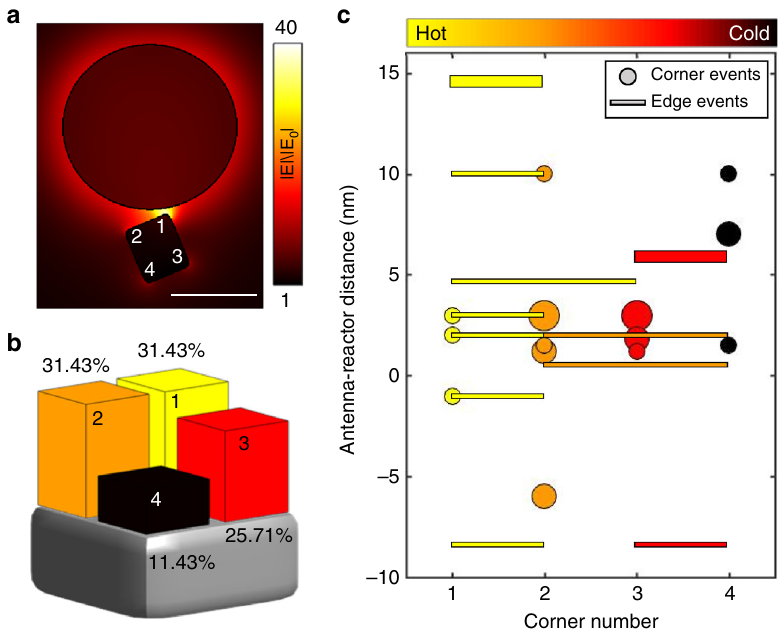
Fig. 4 The effect of electromagnetic hot spots on the phase transformation reaction. a Calculated fi eld enhancement for the antenna (Au) – reactor (Pd) system under planewave excitation at 690 nm. The corners of the Pd nanocube are labeled 1-4 with 1 being the corner closest to the hot spot and 4 the farthest. Scale bar is 50 nm. b Distribution of plasmon-induced phase transformation events by corner number. c Distribution of plasmon-induced phase transformation events with respect to the distance between the nanodisc (antenna) and the nanocube (reactor). Negative antenna-reactor distance values correspond to a physical overlap between the nanodisc and the nanocube. The size of the markers corresponds to a single unloading event (small markers), 2 unloading events (medium markers) and 3 unloading events (big markers). Edge events are marked with bars spanning the two corners comprising the edge. For the summary analysis of b , we assign each edge unloading event to one corner number (the lower corner